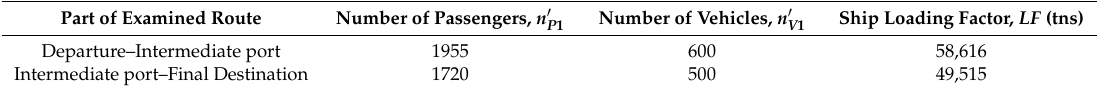
Table 2. Data for Ship